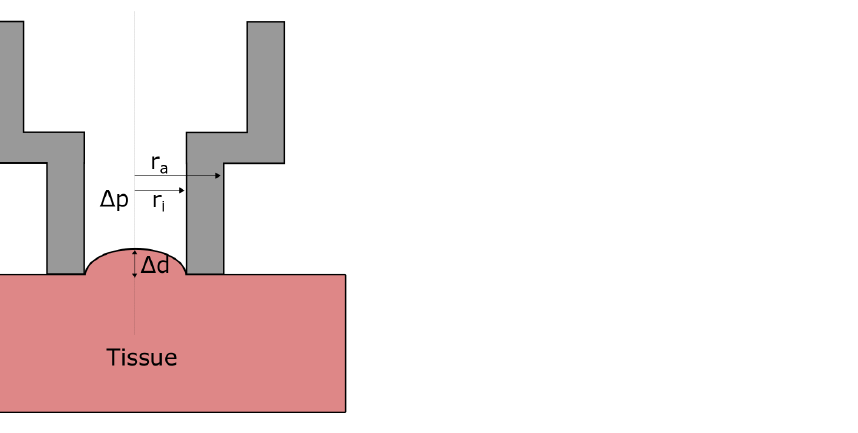
Figure 1. The principle of pipette aspiration technique. The negative pressure difference ∆ p aspirates the tissue in the center of the pipette to the displacement ∆ d .